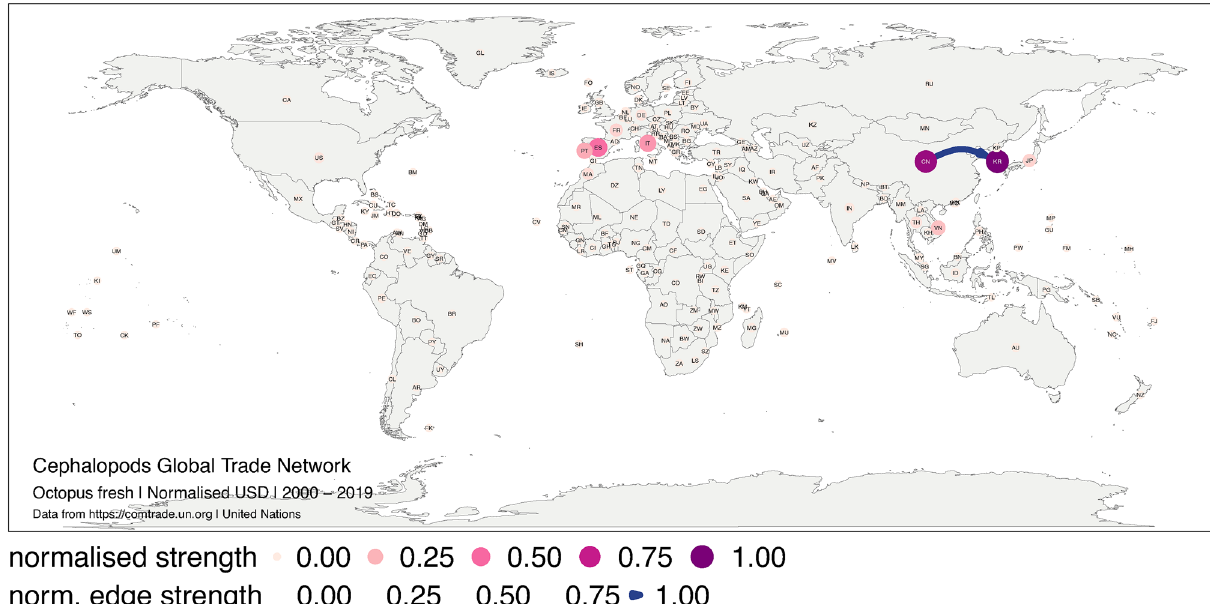
Figure 4. Global trade network for octopus live, fresh or chilled between 1 January 2000, and 31 December 2019 in monetary value (USD). The numbers correspond to the normalised strength for the monetary value. Each node represents a trader, and each edge represents the export–import relationship between two traders. The size and colour of the node represent the relative importance of the trader in the network in terms of its strength. The width and colour of the edge represent the relative importance of the relationship between two traders in terms of their edge strength. The figure was created with R 12 (https:// cran.r- proje ct. org) packages: “ggplot2” v.3.2.1 13 (https:// ggplo t2. tidyv erse. org), “ggmap” v.3.0.0 29 (https:// github. com/ dkahle/ ggmap) and